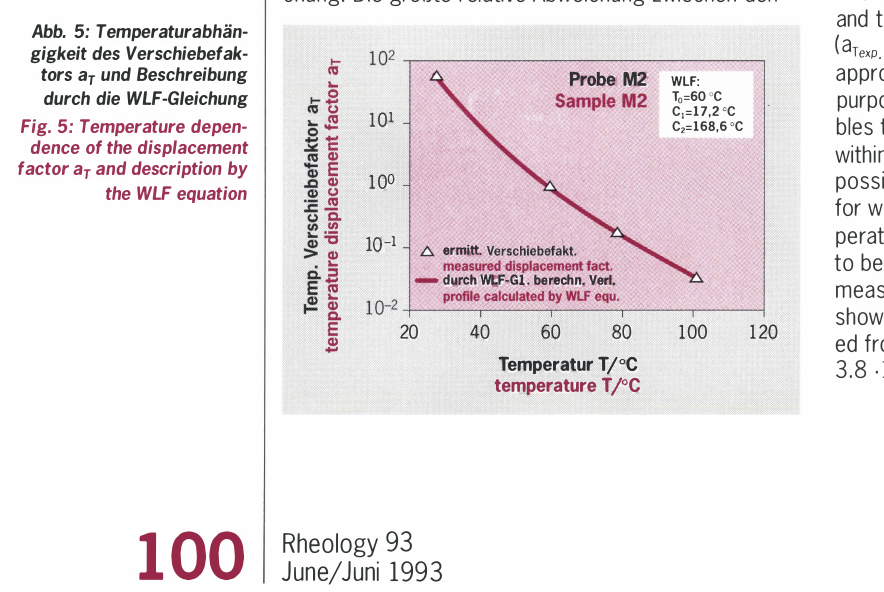
Abb. 5: Temperaturabhiin­ gigkeit des Verschiebefak­